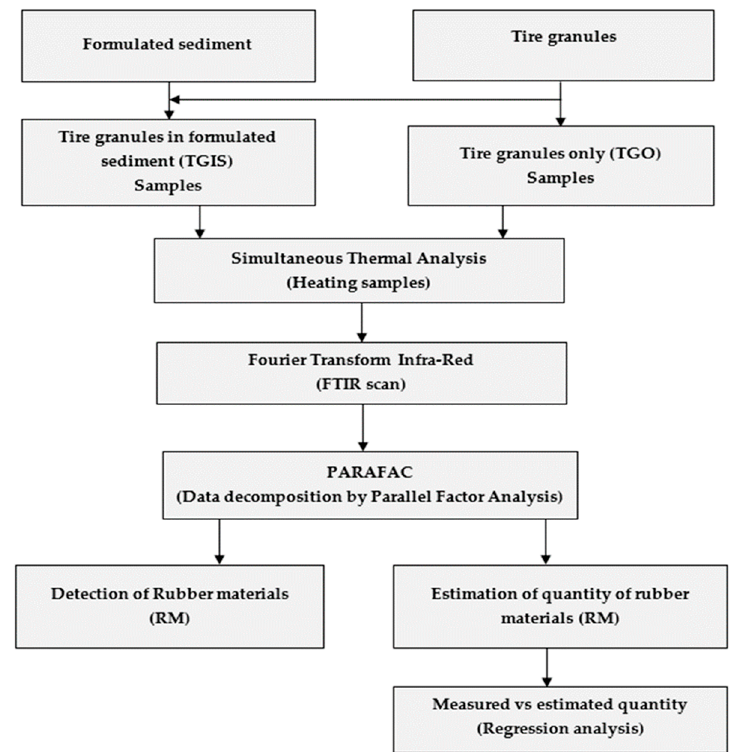
Figure 1. Graphical presentation of flow of the experiment (sample preparation and sampling, sample heating, Fourier Transform Infra-Red (FTIR) scanning, data decomposition, rubber material detection (RM), estimation of quantity of rubber materials (RM), and regression analysis).